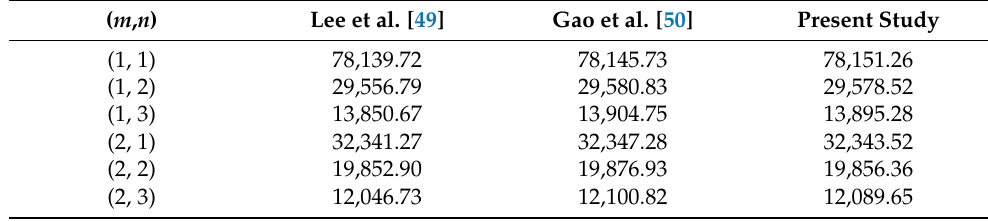
Table 2. Comparison of a dimensionless axial static buckling load P cr L 2 / ported orthotropic cylindrical